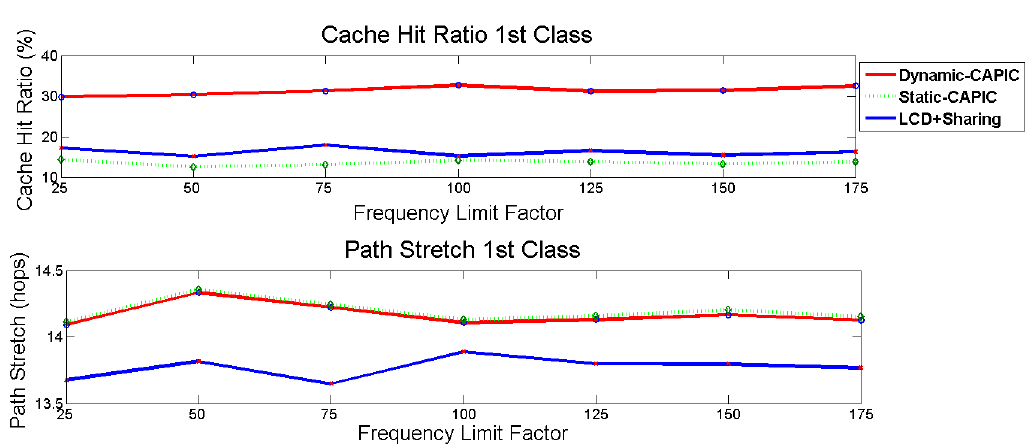
Figure 8. Cache hit ratio ( above ) and path stretch ( below ) 1st class of Dynamic-CAPIC, Static-CAPIC, and LCD+sharing scheme.